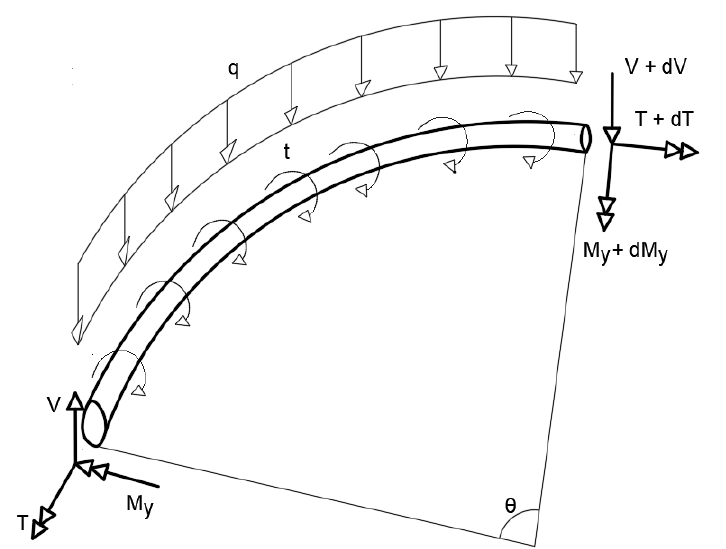
Figure 3. Differential curved bar